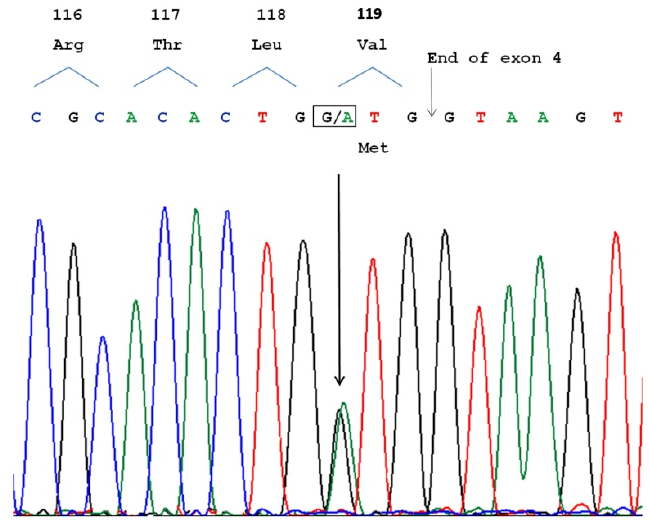
Figure 1. Automated sequence analysis of SOD1 gene exon 4 showing the heterozygous mutation c.355G>A (arrow). The change GTG to ATG at codon 119, resulting in the substitution of methionine for valine in the SOD1 protein (p.V119M), is displayed in the box.